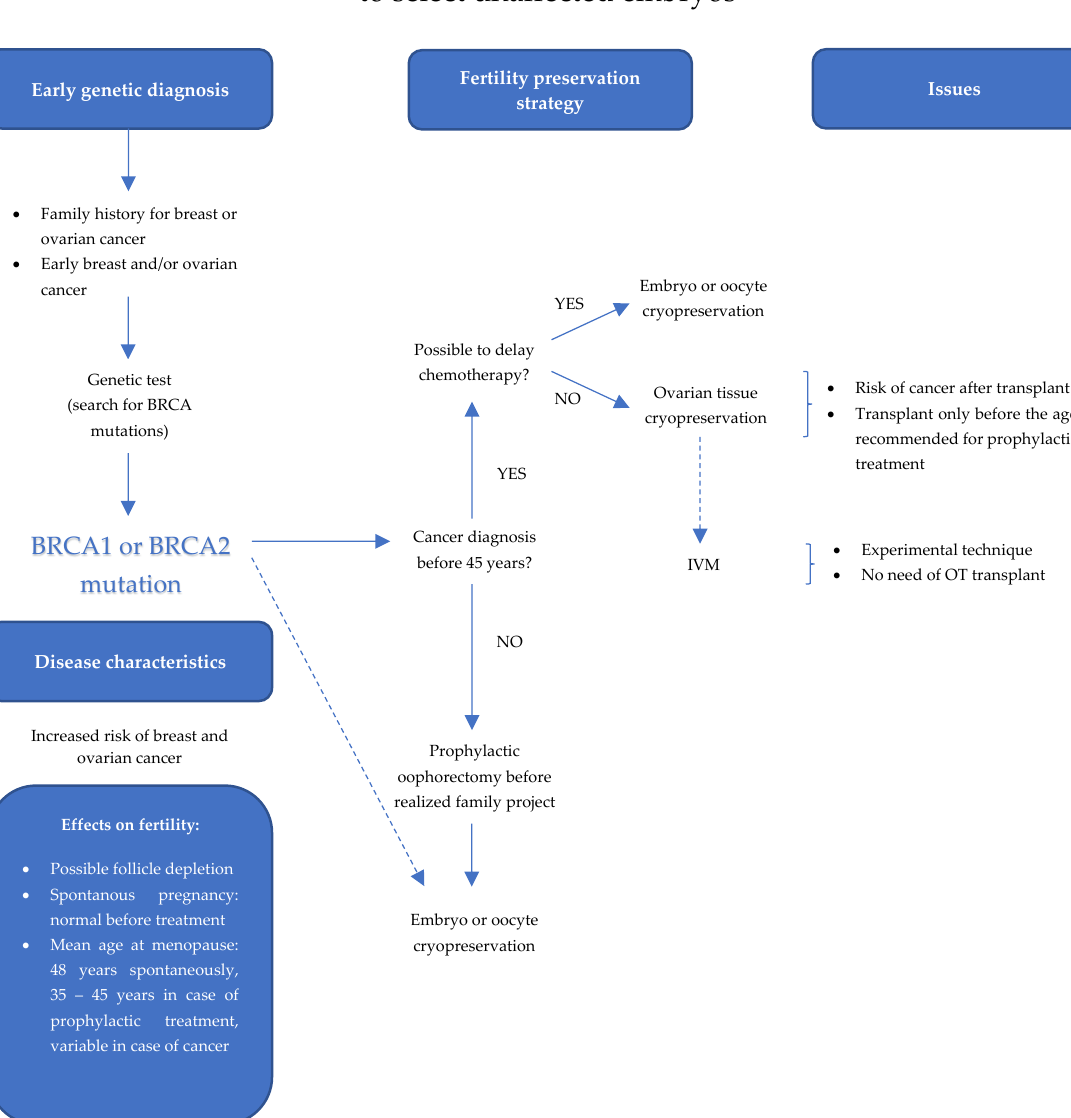
Figure 2. Fertility preservation strategy in patients with BRCA genes mutations.